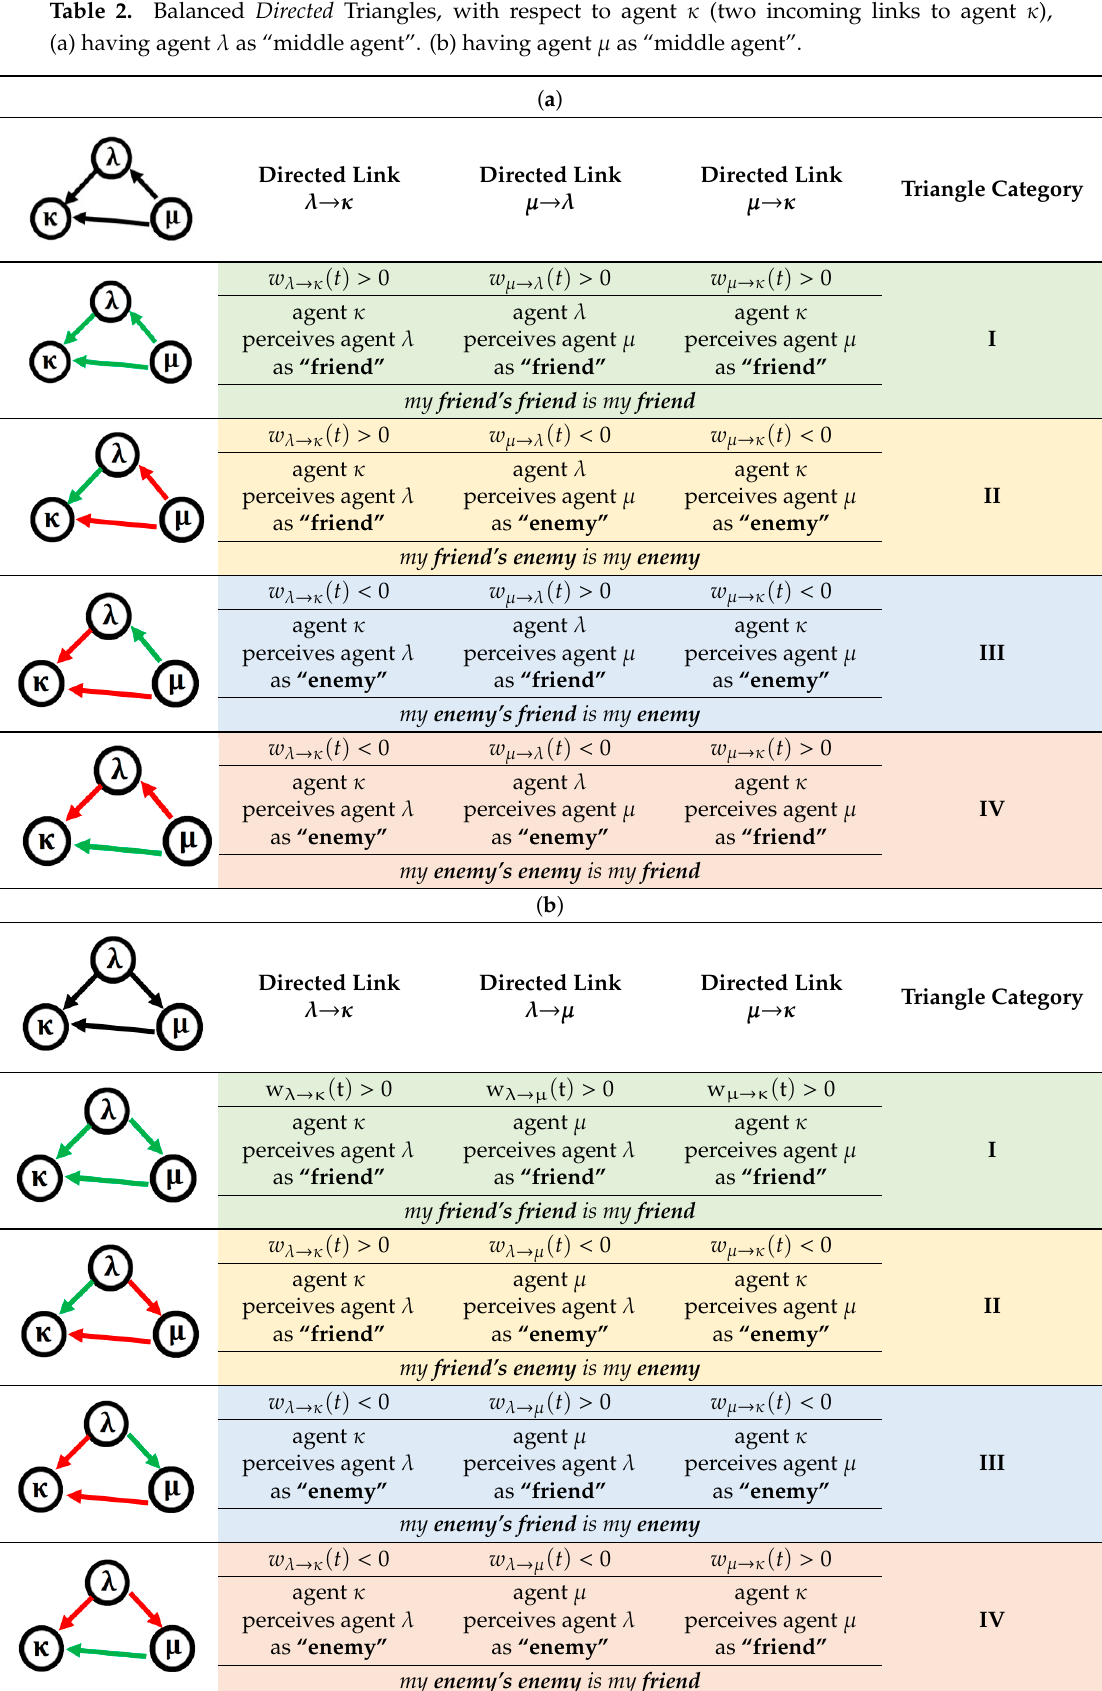
Table 2. Balanced Directed Triangles, with respect to agent κ (two incoming links to agent κ ), (a) having agent λ as “middle agent”. (b) having agent µ as “middle agent”.